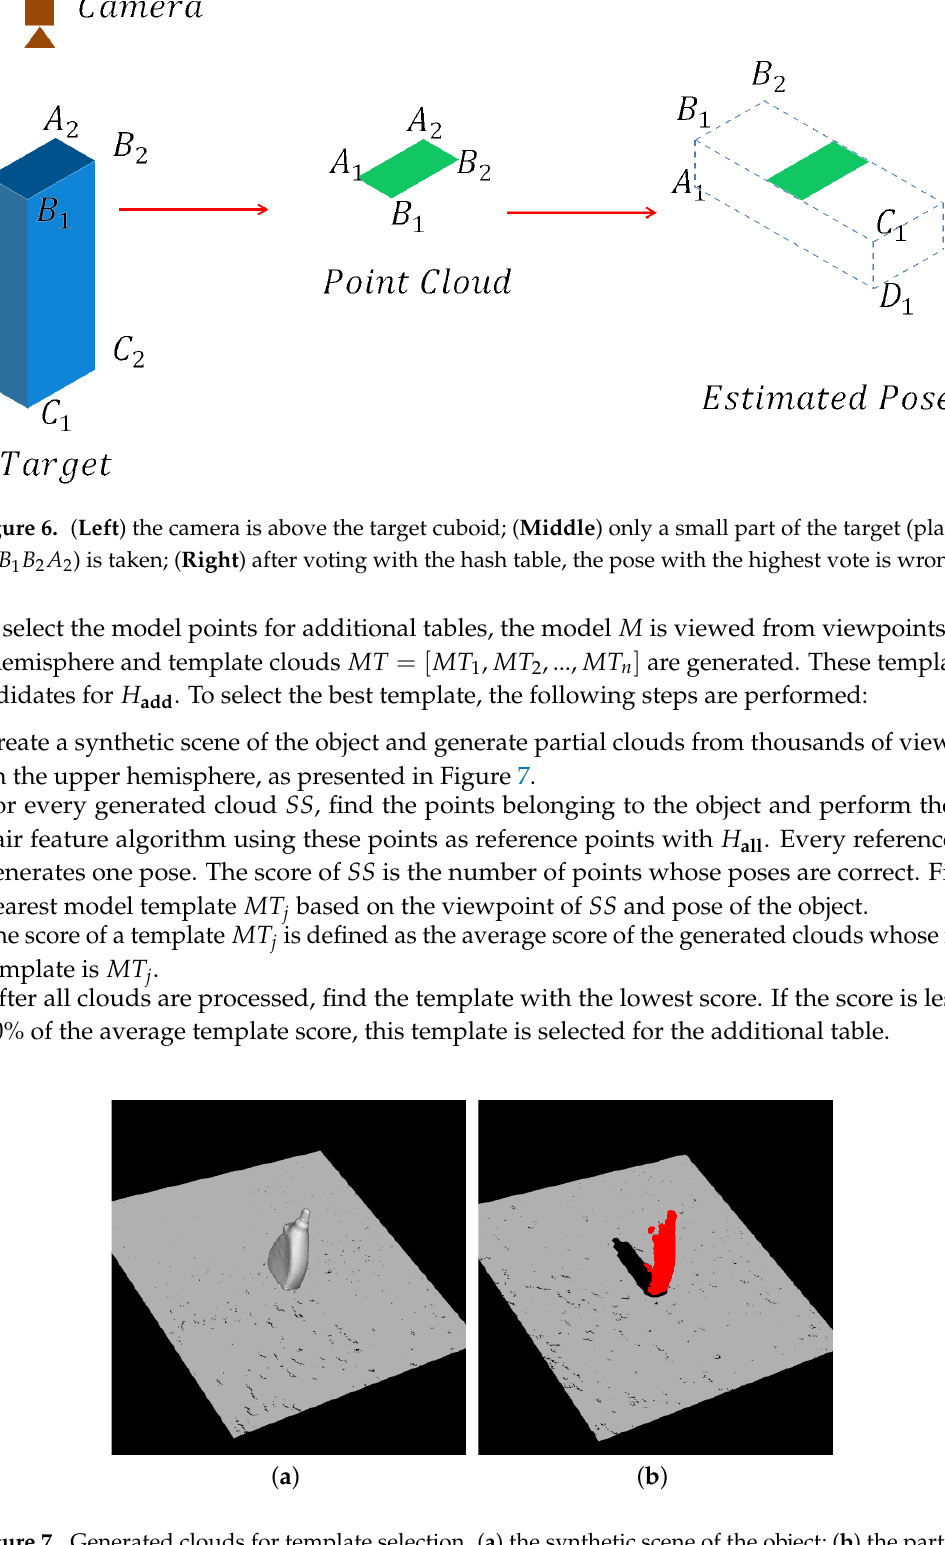
Figure 7. Generated clouds for template selection. ( a ) the synthetic scene of the object; ( b ) the partial cloud from a viewpoint. The red points belong to the